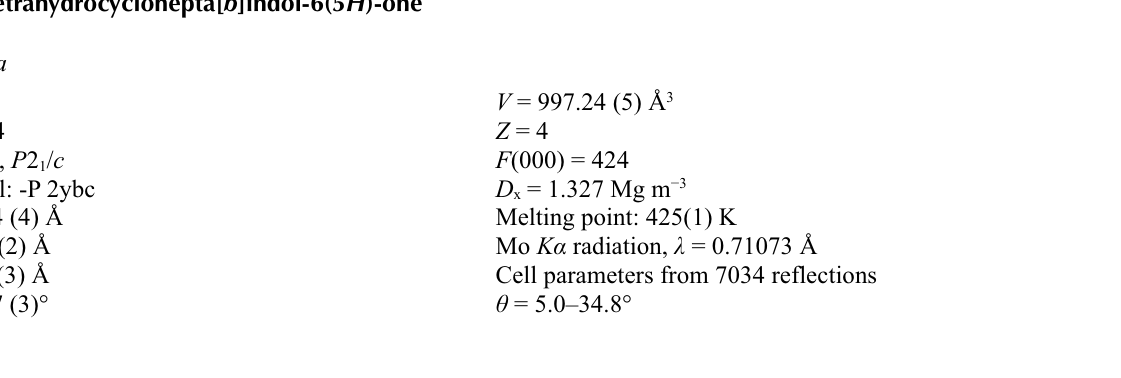
The molecular packing of the title compound, viewed down the b axis. Dashed lines indicate hydrogen bonds. H atoms not involved in hydrogen bonding have been